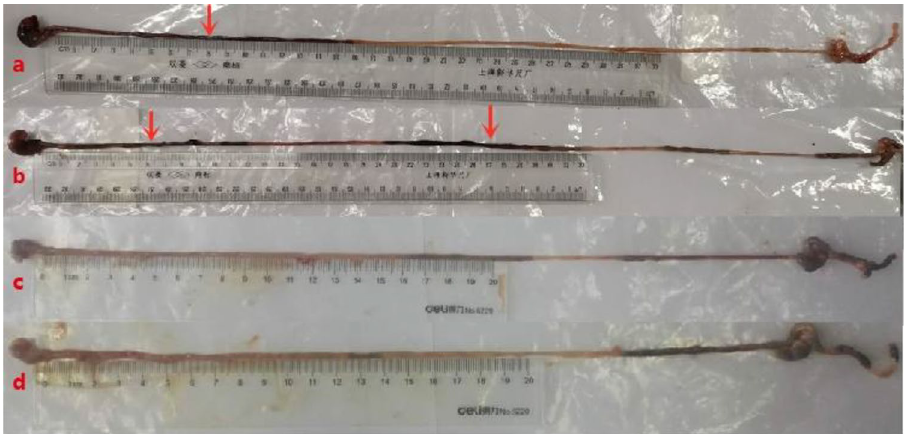
Figure 3. The emptying of nutritious semi-solid paste in the gastrointestinal tract in mice at different digestion times. From left to right, the image shows the mouse stomach, small intestine and cecum; black represents the location of the nutritional semi-solid paste. ( a ) GIT of mice at 10 min after gavage. ( b ): GIT of mice at 20 min after gavage, ( c ) GIT of mice at 360 min after gavage. ( d ): GIT of mice at 420 min after gavage.